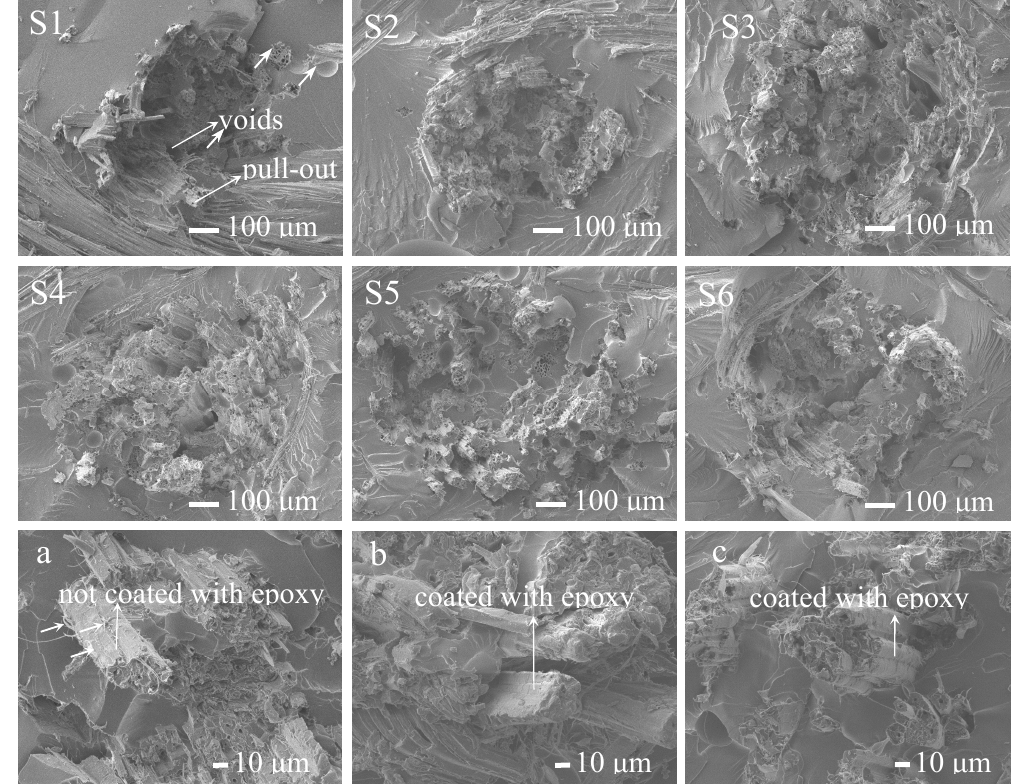
Figure 7. SEM analysis of tensile fracture surfaces: S1 − S6 are the tensile fracture surfaces of the laminated composite materials with immersion times of 0, 10, 30, 60, 90, and 120 min, respectively. a, b and c are the partial enlarged electron microscope images of S1, S2 and S3 respectively.